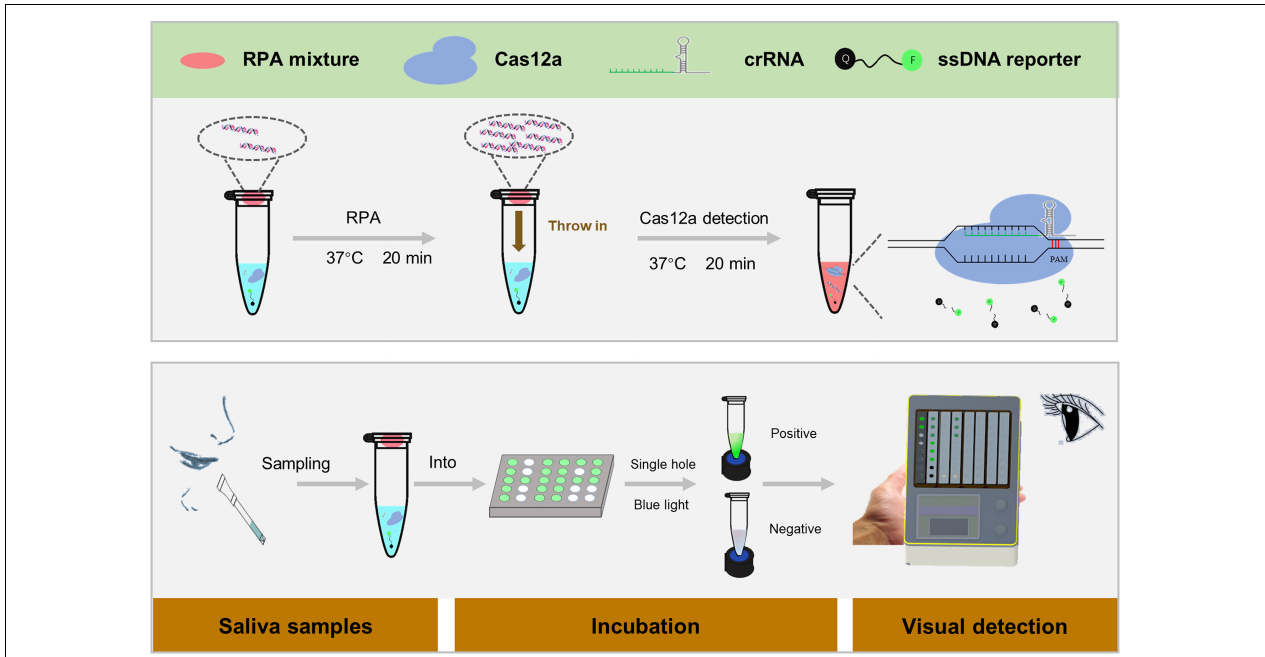
FIGURE 1 | Scheme of the one-tube RPA-CRISPR assay platform for Helicobacter pylori detection with the naked eye. Within 5 min, the saliva sample was processed in boiling water to obtain DNA, and 1 µ l of the treated sample was added to the RPA mixture system for CRISPR detection of H. pylori . The specific protocol is as follows: 30 µ l of CRISPR/Cas12a reaction mixture is added to the bottom of the tube, and 9 µ l of RPA unreacted mixture and 1 µ l of the sample are added inside the tube’s lid, which is placed on Pad-VATA for incubation. After 20 min incubation at 37 ◦ C, the amplified DNA sample inside the tube’s lid is mixed with the CRISPR reaction solution at the bottom of the tube by shaking the tube. The trans-cleavage activity is instantly activated to cut any ssDNA-reporter once the Cas12a enzyme is specifically identified with the target DNA; meanwhile, the fluorescent signal can be recognized by the naked